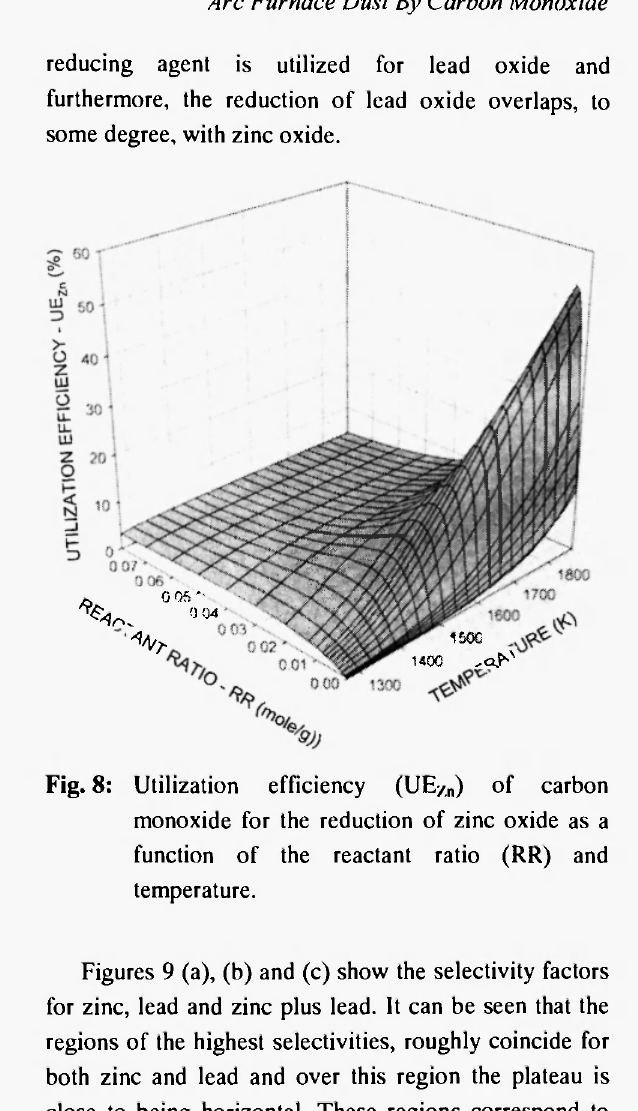
Fig. 8: Utilization efficiency (UE Zn ) of carbon monoxide for the reduction of zinc oxide as a function of the reactant ratio (RR) and